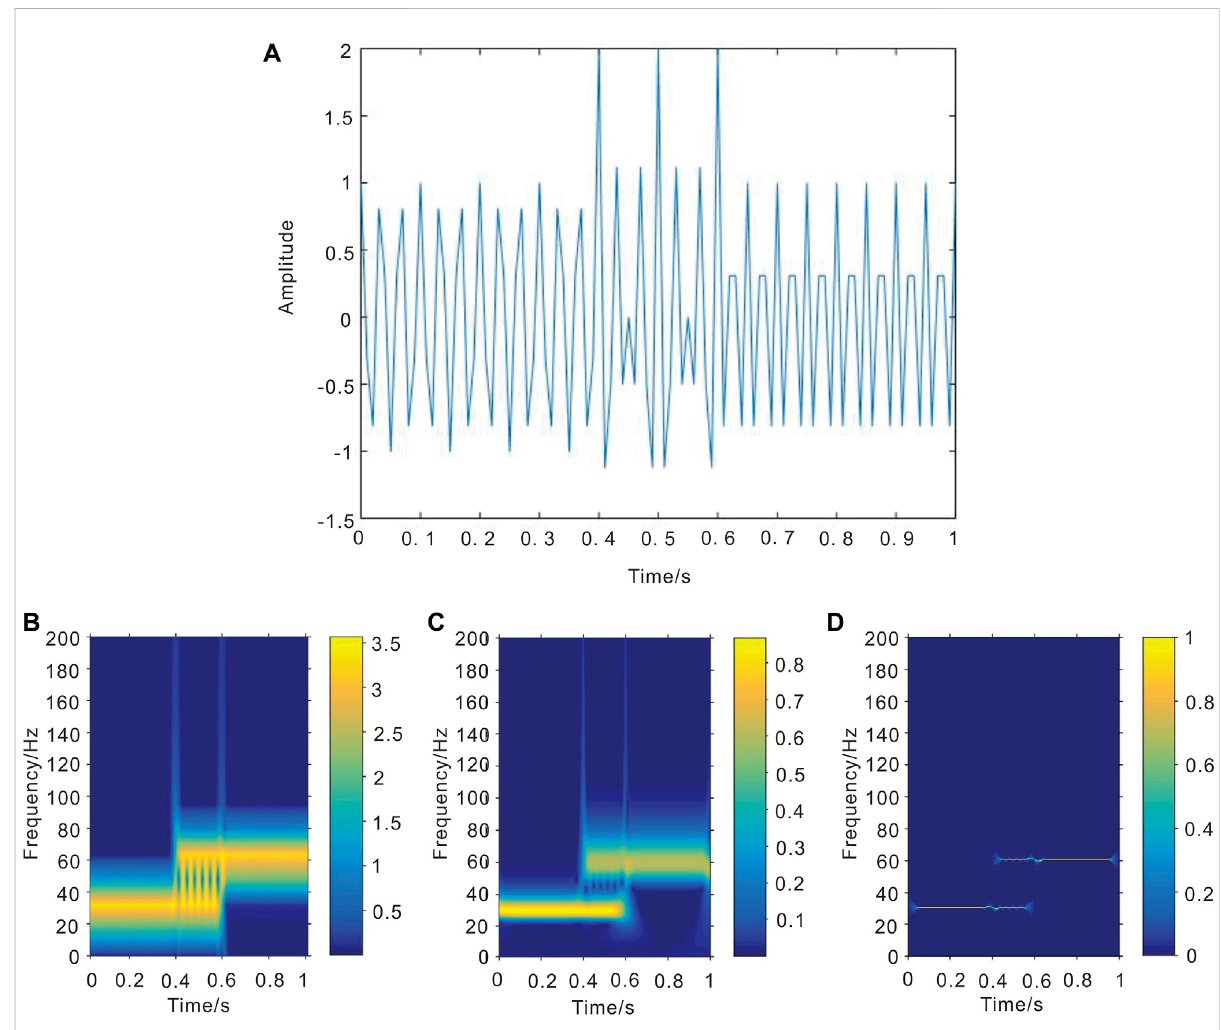
FIGURE 1 Results of time-frequency analysis of non-noisy narrowband signals (A) The original signal s ( t ) (B) STFT (C) GSTFT (D)